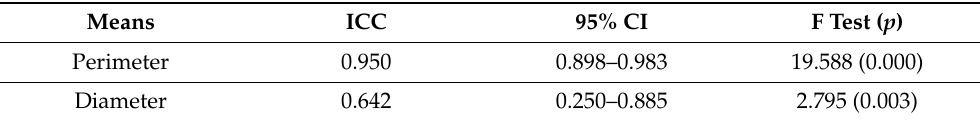
Table 1. Diameter and Perimeter’s ICC in each anatomical landmarks